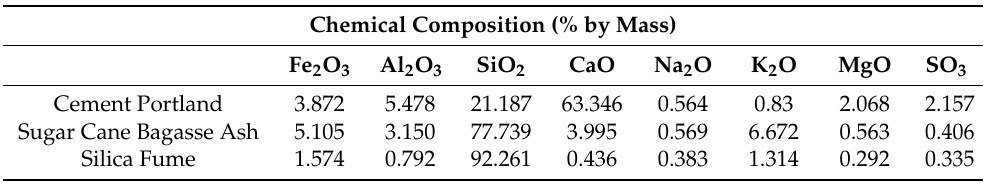
Table 1. Chemical composition of the cementitious materials obtained by XRF.